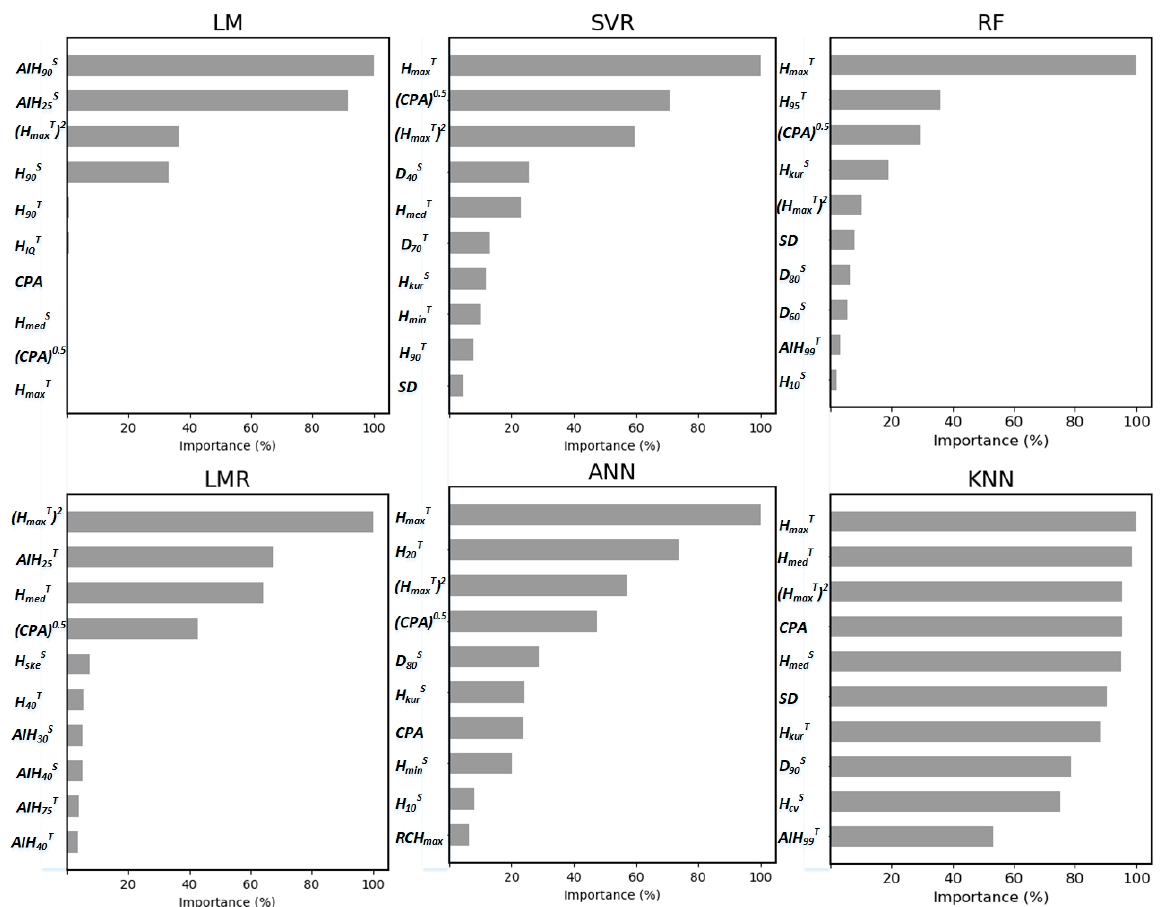
Figure 8. The relative importance of the 10 most important metrics for each DBH prediction method. LM used only used seven metrics to predict the DBH of individual trees. A description of the LiDAR-derived metrics is given in Table 3. Table 5. Summary of hyper-parameter tuning and accuracy assessment results in cross-validation for different regression